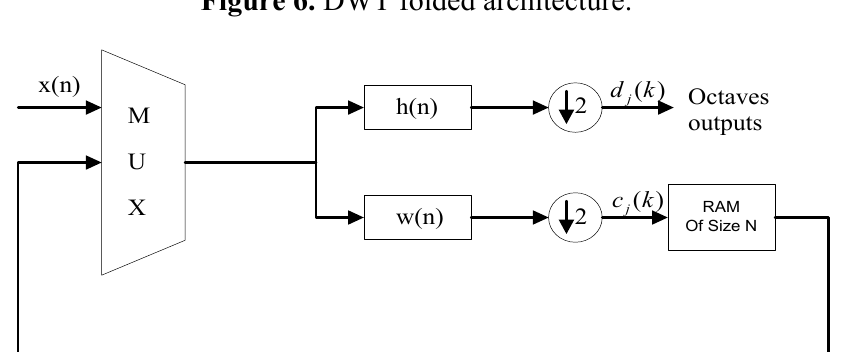
Figure 6. DWT folded